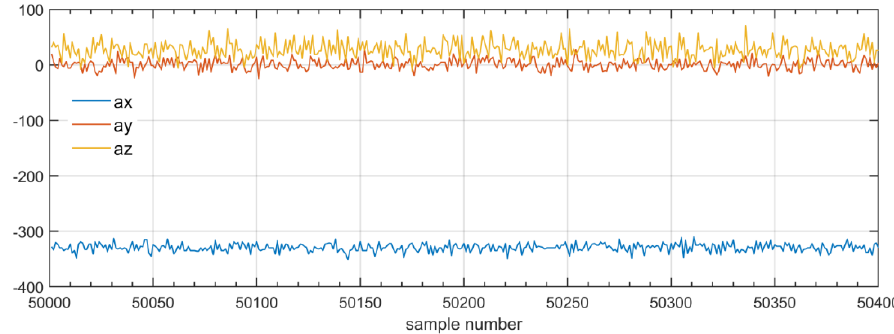
Figure 6. Raw acceleration data from the sensor prototype.